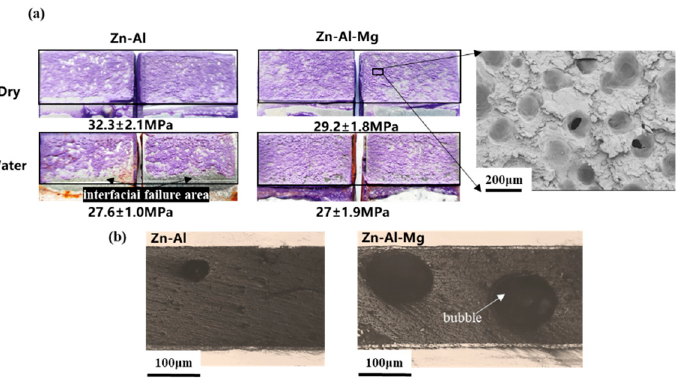
Figure 5. ( a ) Adhesion strength and fracture surfaces of dry and water joint and ( b ) cross section of dry joints of the Zn–Al and Zn–Al–Mg galvanized steel